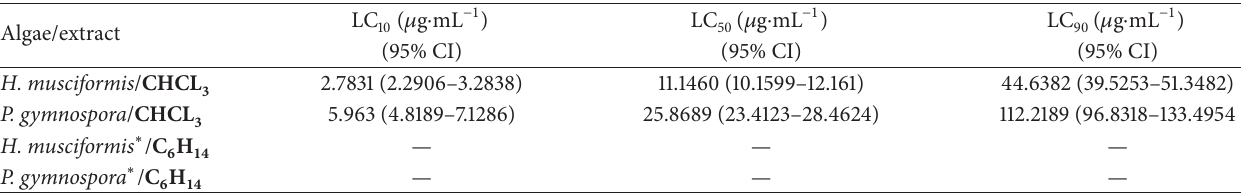
Table 2: Lethal concentration (LC on the beach of Riacho Doce, AL, against B. glabrata.